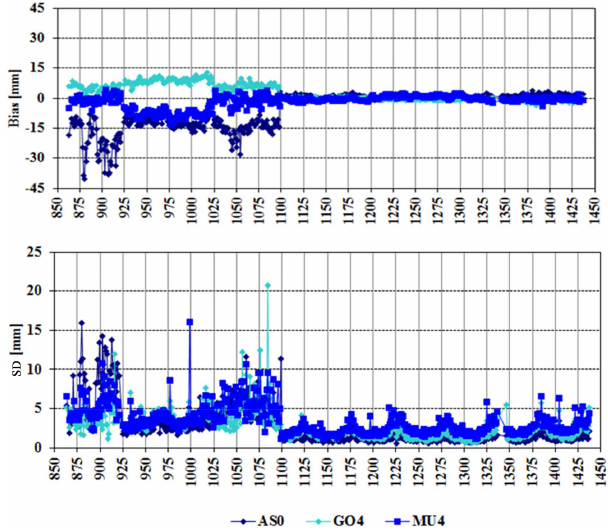
Figure 5. VENE (Venice, Italy) time series of ZTD biases and stan- dard deviations for the three contributing solutions AS0, GO4 and MU4 with respect to the combined solution for the period 21 July 1996–28 July2007 (GPS weeks 0863–1437). GO0 and GO1 are not shown here, since they are very close to GO4.